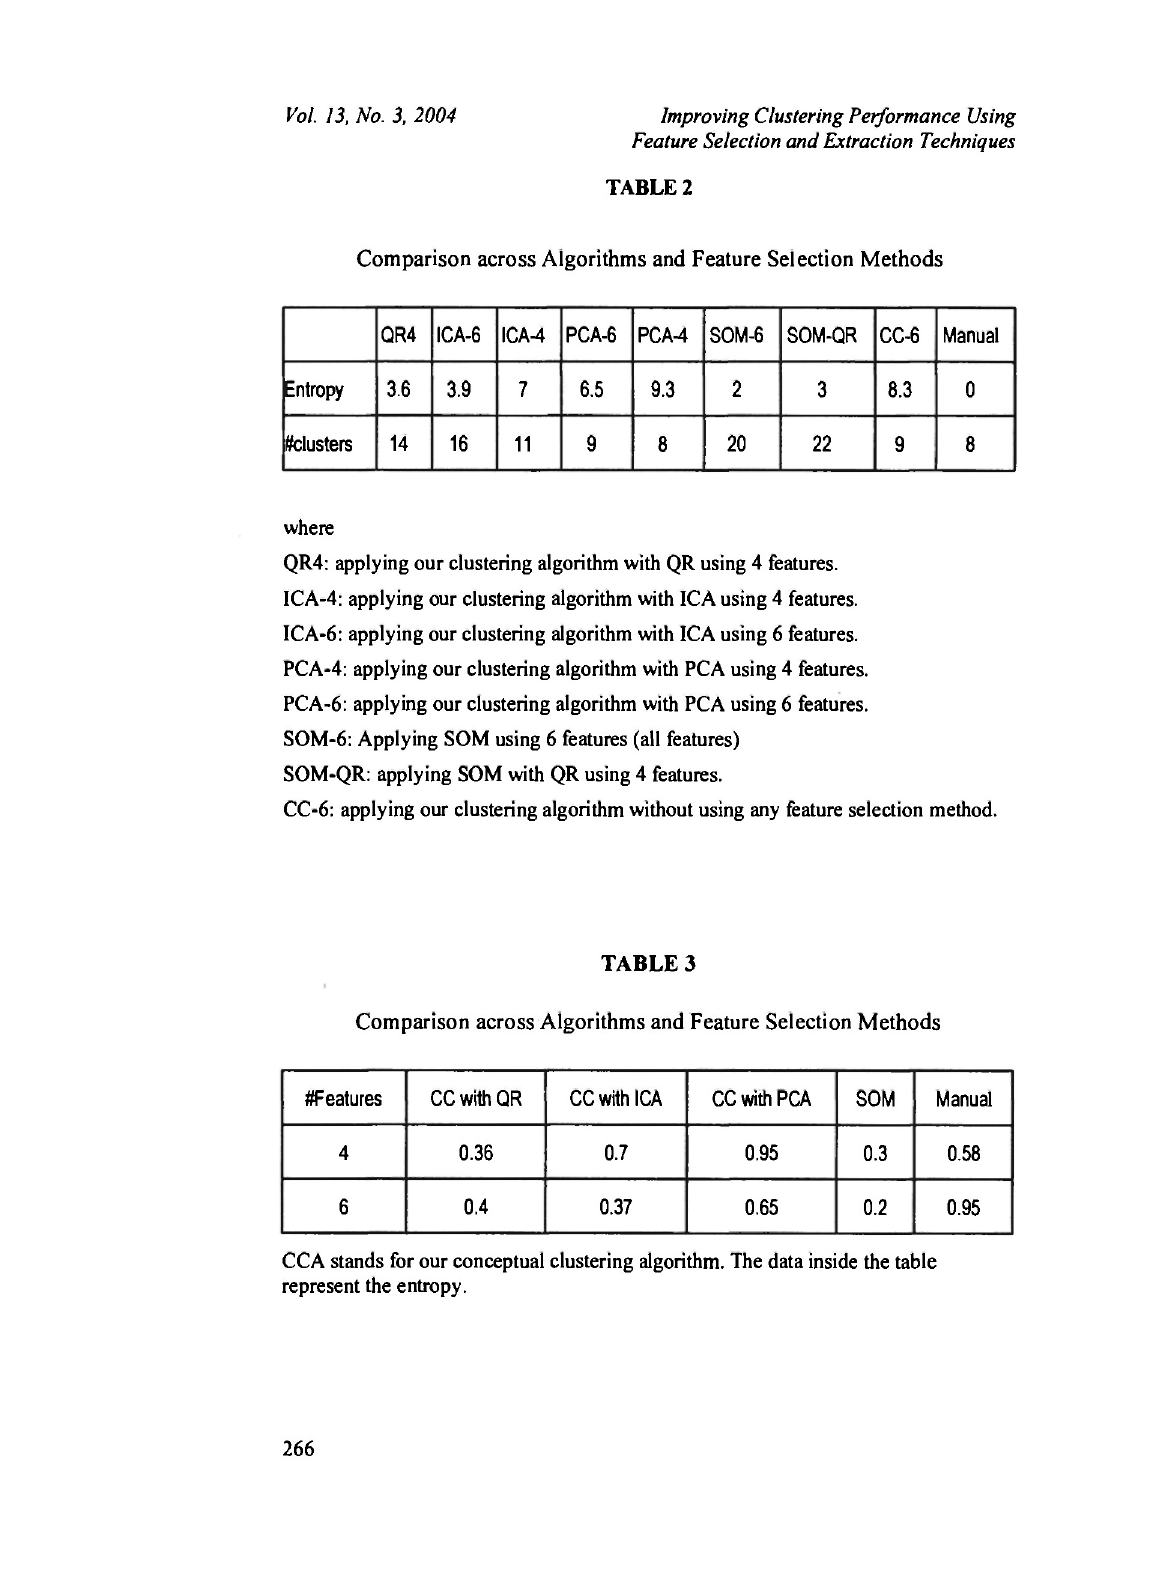
Comparison across Algorithms and Feature Selection Methods